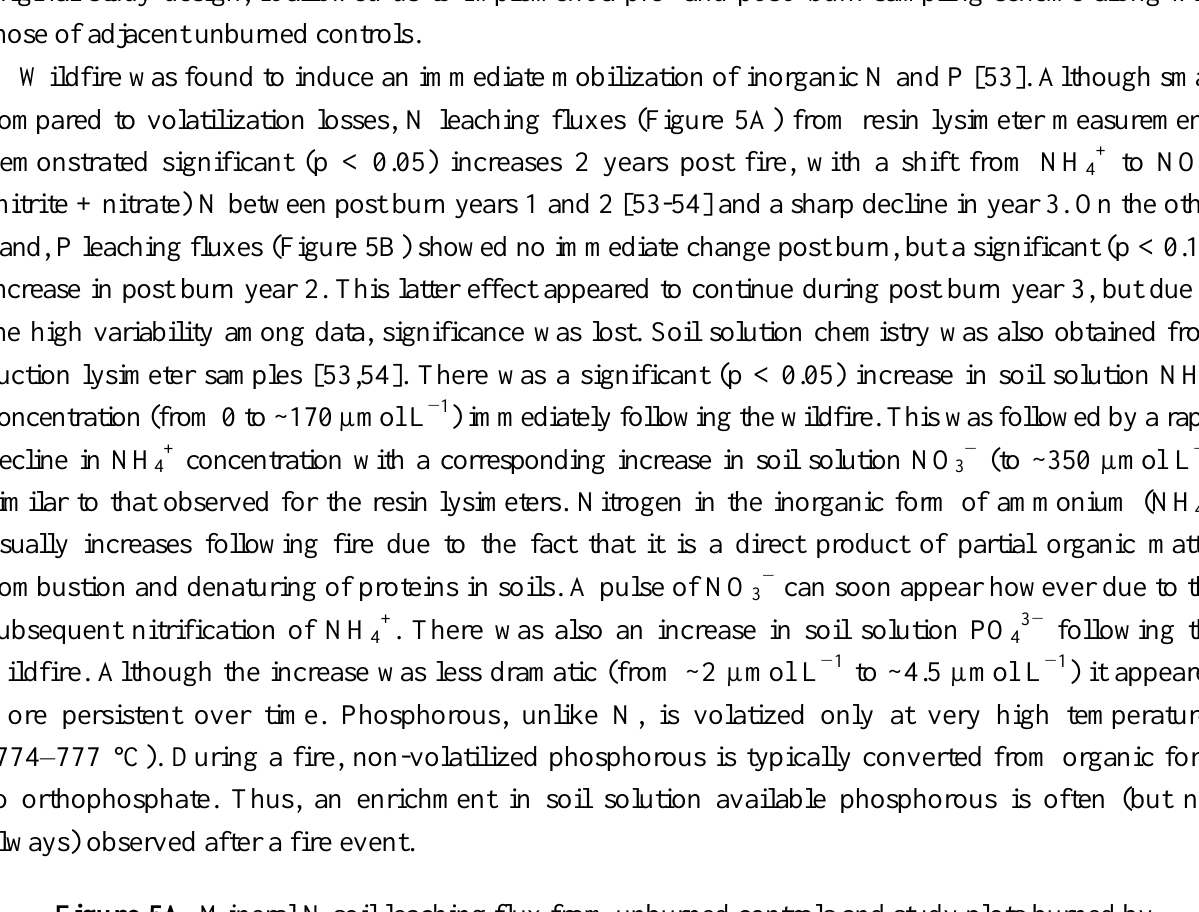
Figure 5A. Mineral N soil leaching flux from unburned controls and study plots burned by wildfire. Significant differences are noted as p < 0.10 (*), p < 0.05 (**), or p < 0.01 (***). Adapted from